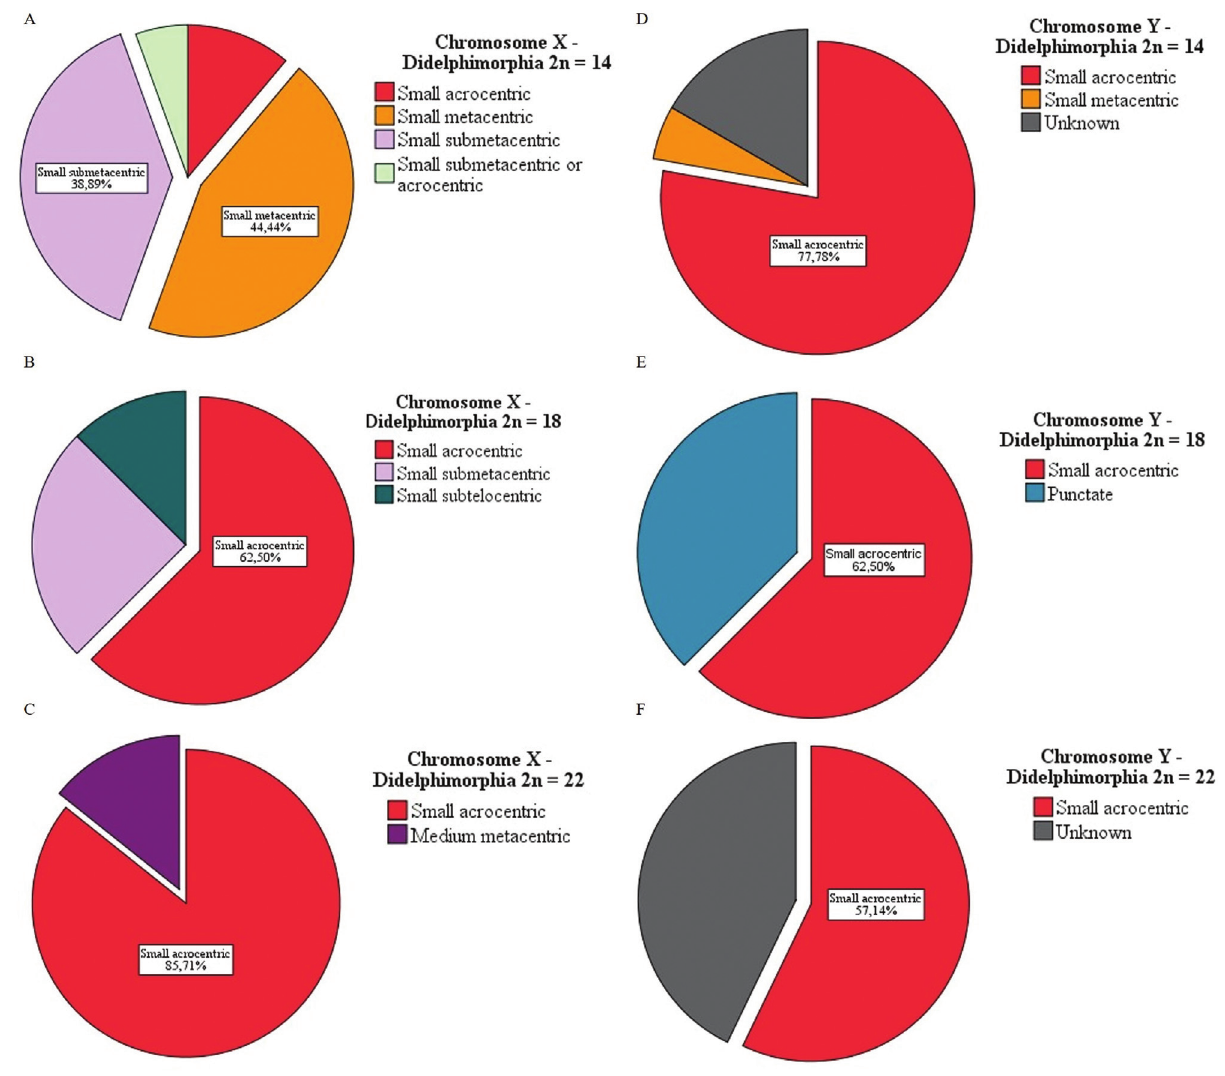
Figure 4 - The most common chromosomal forms for the sexual pair found among marsupials. (A and B) 2n = 14 to Caluromys sp., Cryptonanus sp., Garcilinanus sp., Marmosa sp., Marmosops sp., Metachirus sp., Micoureus sp. and Thylamys sp., (C and D) 2n = 18 to Glironia sp. and Monodelphis